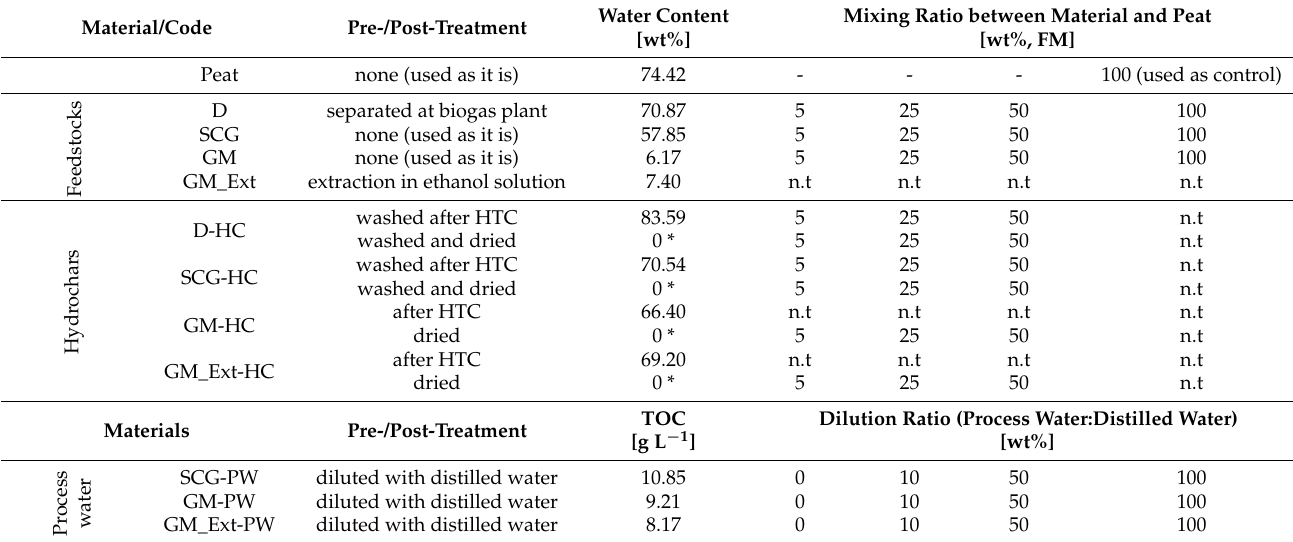
Table 1. Overview of samples